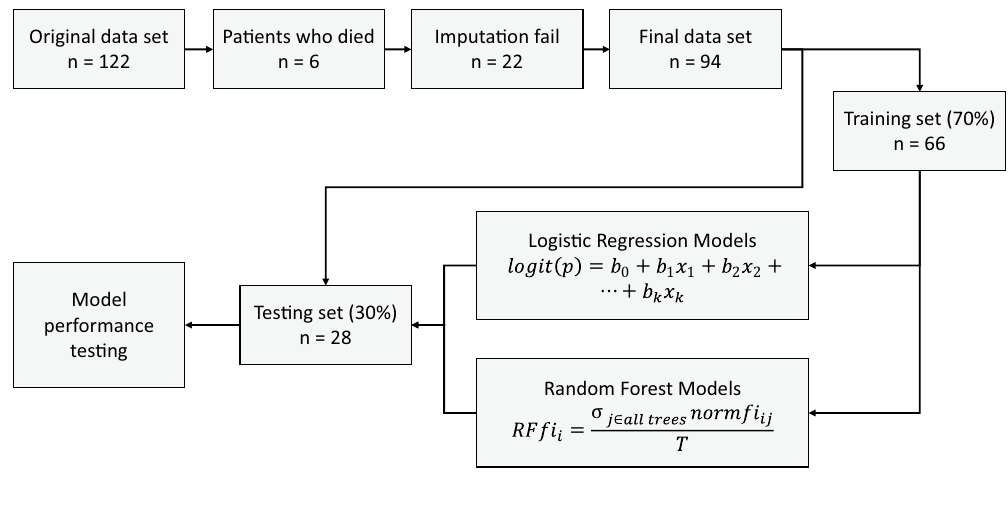
Figure 2. Flowchart over the modelling